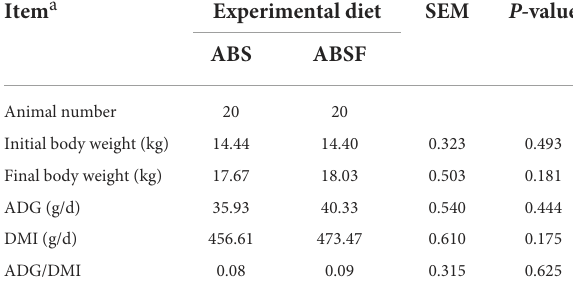
effect on animal growth performance as the ABS it